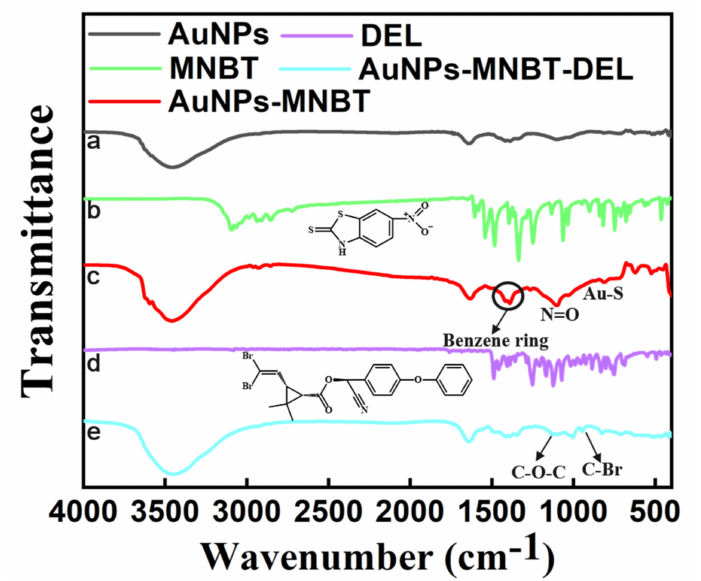
Figure 1. The FT-IR spectra of a—AuNPs, b—MNBT, c—MNBT-AuNPs, d—DEL, and e —DEL-